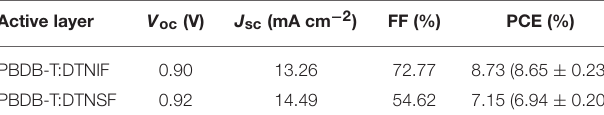
TABLE 2 | Photovoltaic properties of OSCs (under AM 1.5G, 100 mW cm − 2 ). Active layer